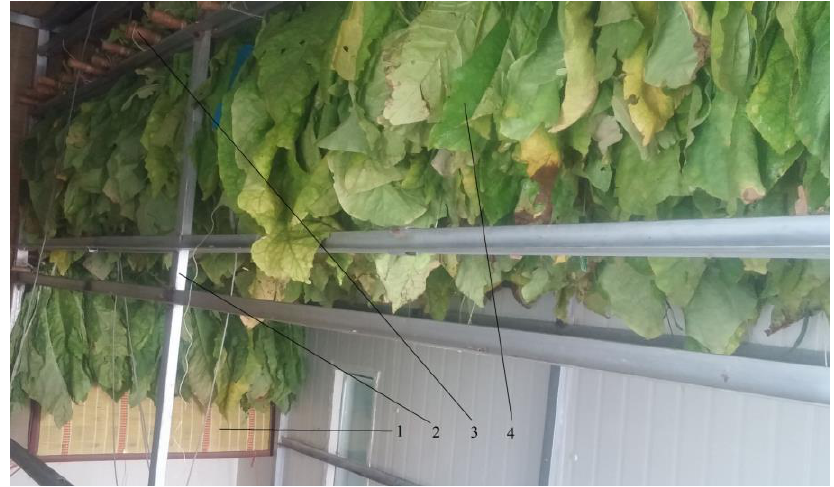
Figure 2. Tobacco curing chamber. 1. Bamboo curtain; 2. Steel frame; 3. Stick of bamboo; 4. Tobacco leaves.